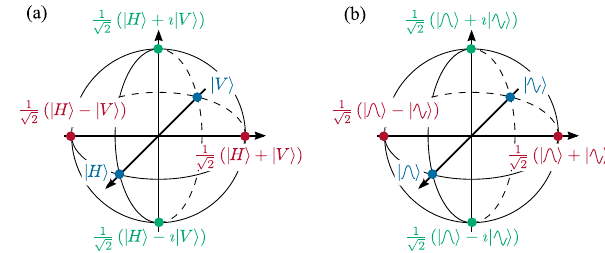
FIG. 2. (a) Poincaré sphere. The logical “ 0 ” and “ 1 ” of a polarization qubit can be encoded in any two diametrically opposite points on the sphere. Typically, horizontal and vertical polarization are deployed. (b) Bloch sphere for TM qubits. Any two orthogonal TMs and their coherent superpositions may be used to encode TM qubits. In this example, the TMs are zeroth- and first-order Hermite-Gaussian